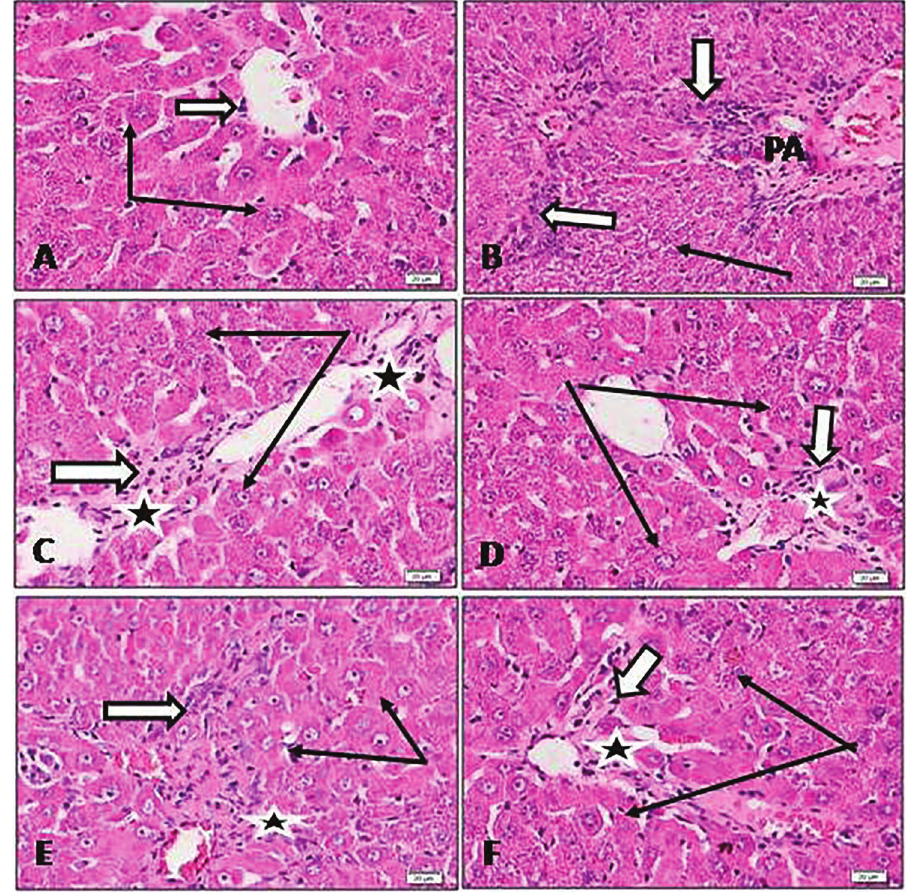
Figure 4. Sections of rat liver stained with H&E ( (cid:3) 20). A , Normal control group showing normal hepatic lobulation and hepatocytes (black arrows). B , Thioacetamide group showing loss of normal architecture and early signs of hepatic fi brosis. There are strands of fi broblasts proliferation between lobules, lymphocytic in fi ltrate (stars), and degenerative changes in hepatocytes (black arrows). C and E , Lower doses of losartan and candesartan groups (5 and 0.1 mg/kg) showing potential improvement of fi brotic changes with moderate restoration of hepatic lobule architecture, moderate hepatocytes degeneration (black arrows), and less in fl ammatory in fi ltrate (stars). D and F , Higher doses of losartan and candesartan groups (10 and 0.3 mg/kg) showing marked improvement with minimal fi brotic changes, mild fi broblast proliferation, minimal in fl ammatory in fi ltrate. Most hepatocytes looked normal with minimal residual degenerative changes (black arrows). White arrows indicate newly proliferating fi